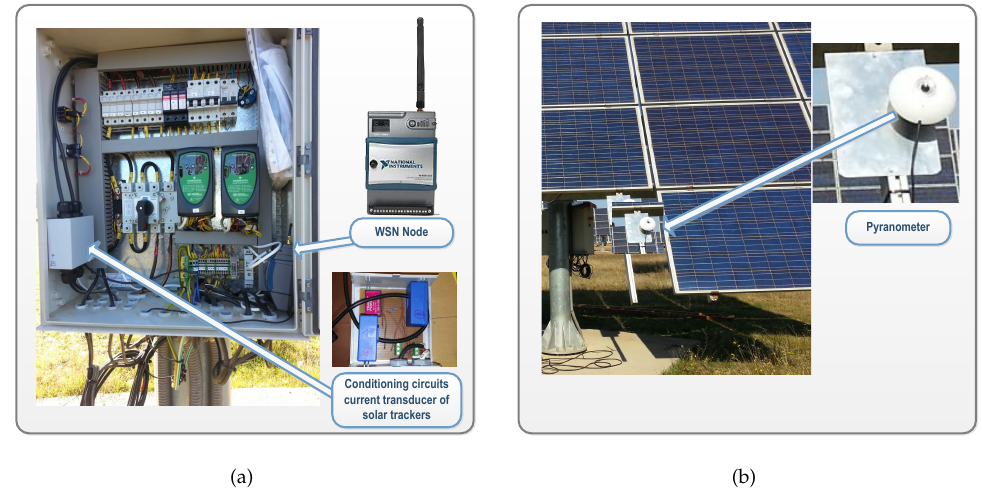
Figure 10. Photovoltaic measurements performed in solar trackers in grid-connected PV plant: ( a ) WSN node and DC current sensors; ( b ) Detail of a